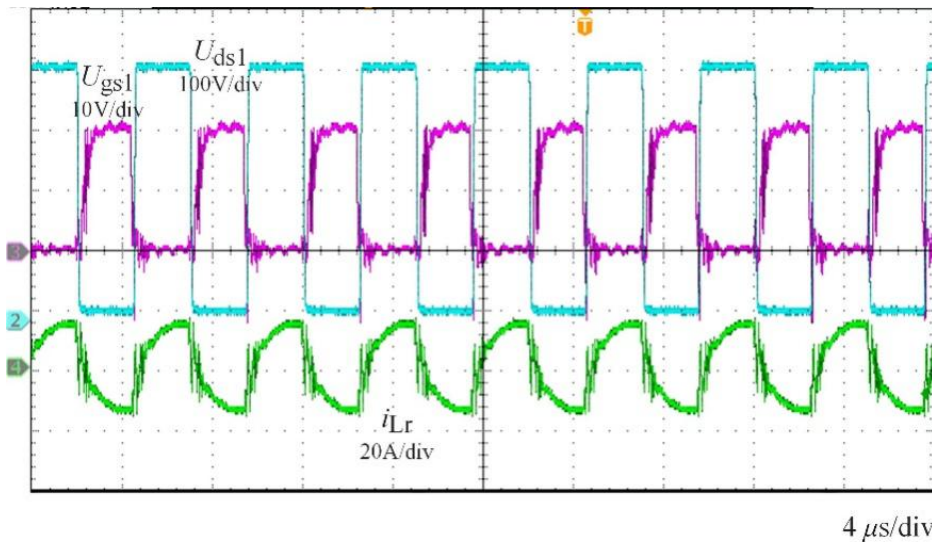
Figure 18. Waveforms using fixed-frequency phase-shift strategy in step-down mode.